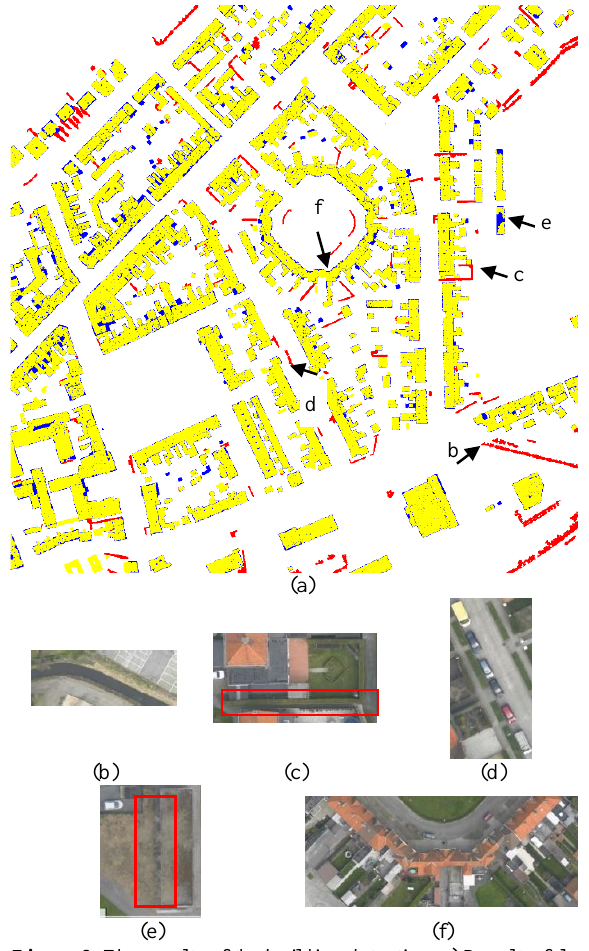
Figure 8 . The results of the building detection. a) Results: false- negative FN (blue), true positive TP (yellow), and false-positive FP (red), (b)-(f) Examples of TP, FP, and FN.